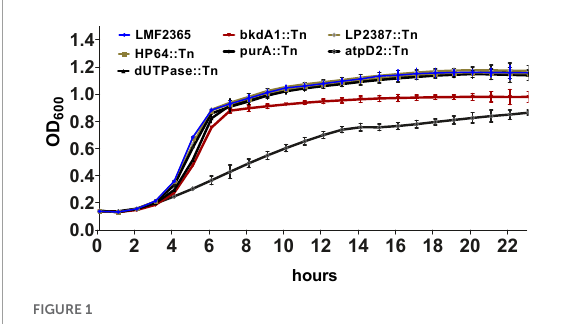
FIGURE1 Growth of the Tn-mutants and wild-type L. monocytogenes in BHI medium at 37 ◦ C for 24 h. The growth kinetic was monitored using optical density measurements at 600 nm. Data represent he means ± standard error of three independent experiments with four